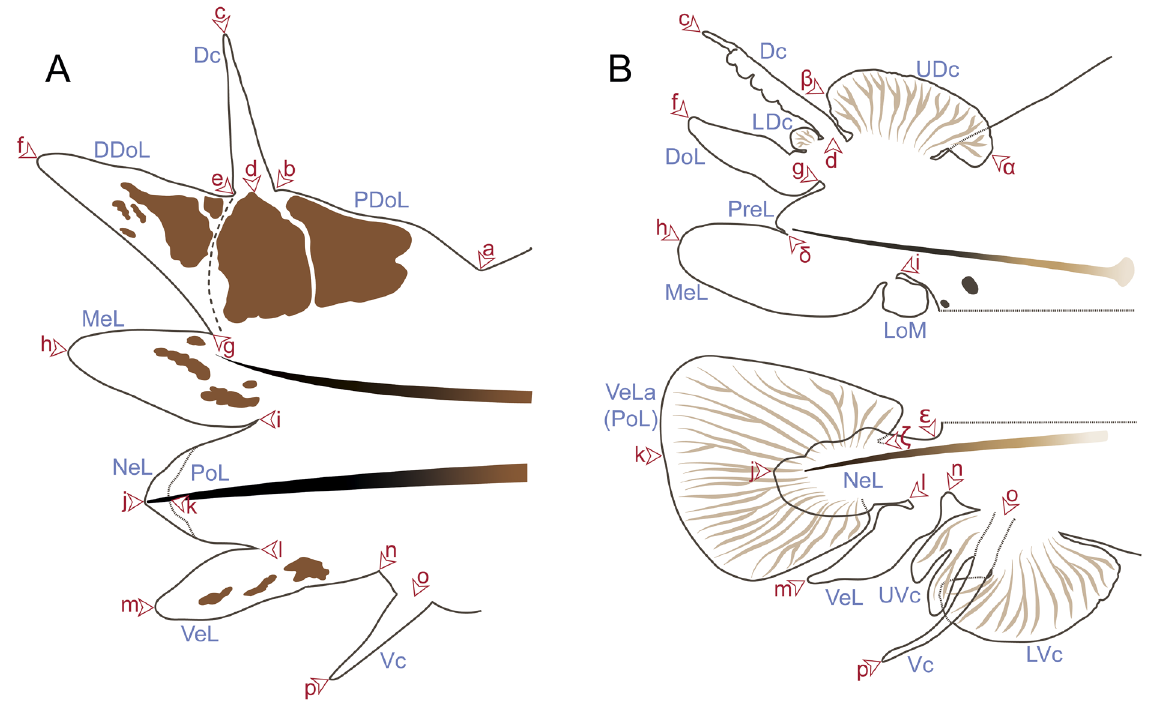
Fig. 1. Parapodial morphology of species of Perinereis Kinberg, 1865 and points used to obtain segments and length ratios of parapodial structures described in this work. Arrows and labels correspond to points used for the measuring parapodial structures as described in Material and methods section. A . Parapodium from posterior chaetiger of Perinereis floridana (Ehlers, 1868) (ECOSUR P1100). B . Parapodium from natatory region of Perinereis floridana (LACM-AHF 7376). Abbreviations: Dc